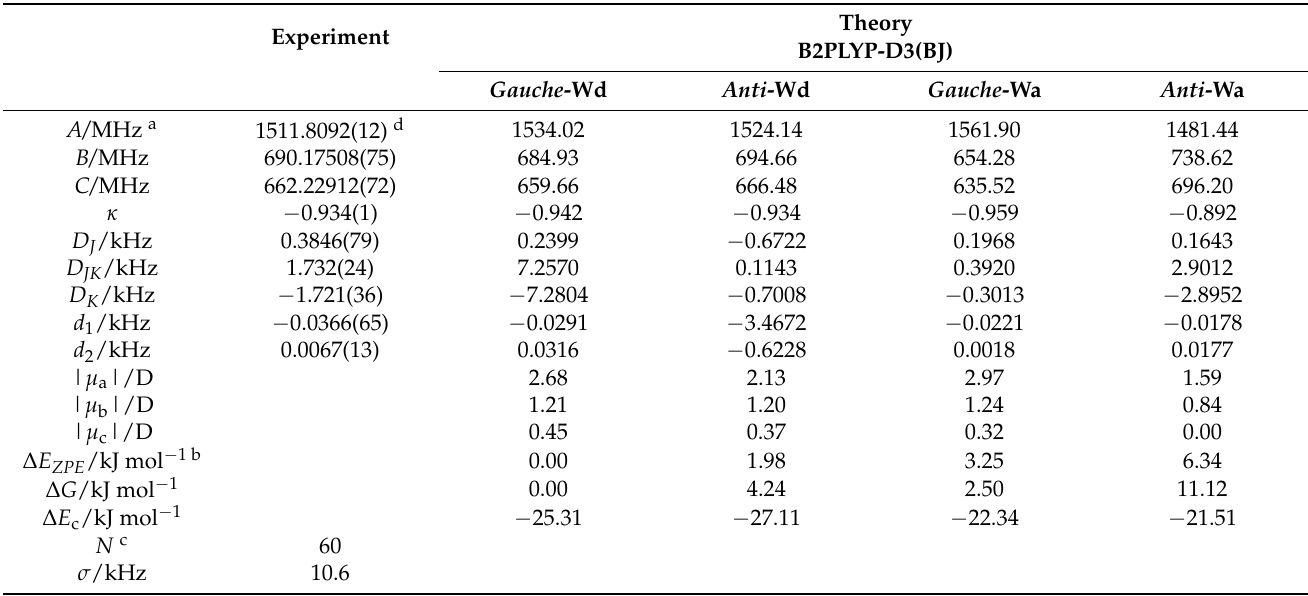
Table 2. Rotational parameters for the 2-adamantanol